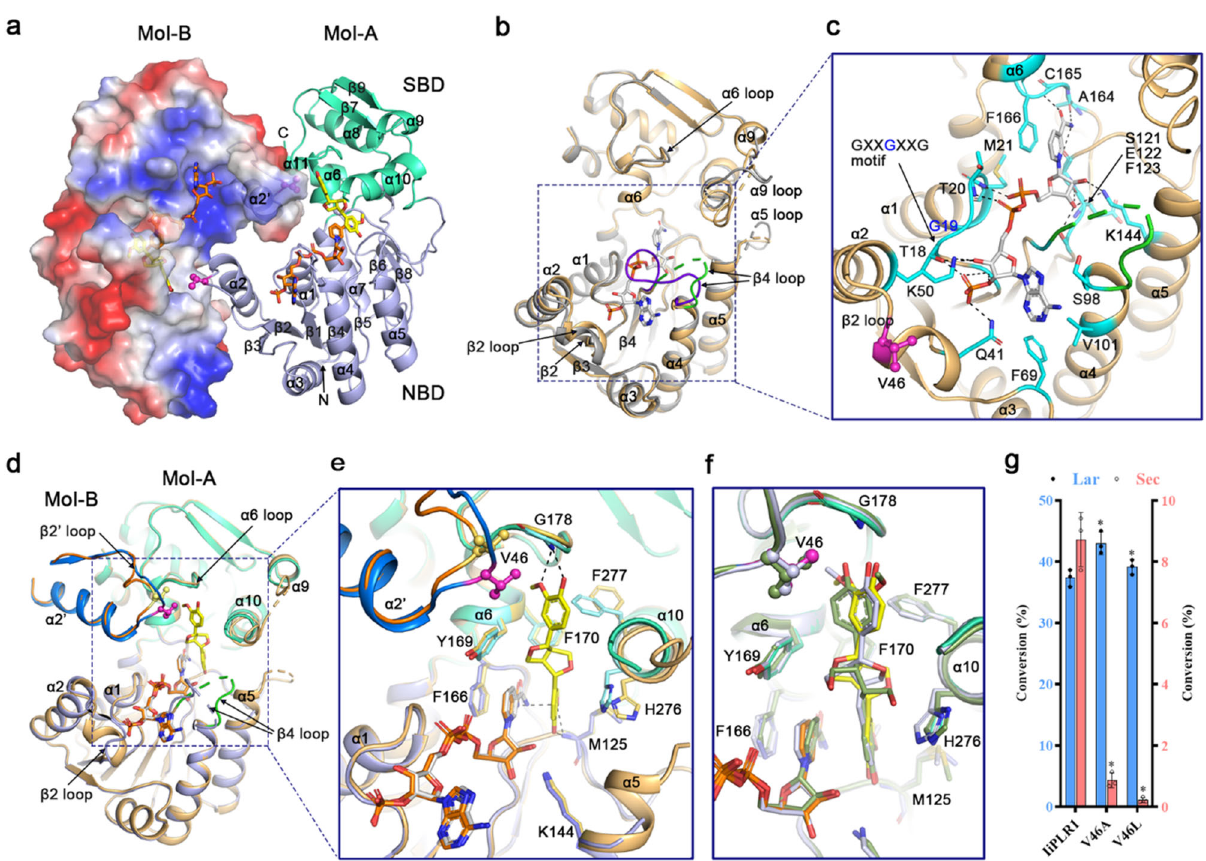
Fig. 2 Structural mechanism of continuous catalytic reactions by Ii PLR1 based on homodimerization. a Dimer formation of Ii PLR1_NAP_ + PIN. Mol-A is shown as cartoon model, with its NBD and SBD colored in light blue and green cyan, respectively. Mol-B is represented as an electrostatic-surface model, on which blue and red colors represent positive and negative charges, respectively. NADP + and ( + )-pinoresinol are shown as sticks and colored in orange and yellow, respectively. b Conformational changes were assessed by comparing monomer structures of Ii PLR1_apo (gray) and Ii PLR1_NAP (light orange). The NADP + bound to Ii PLR1_NAP is colored gray. The β 4 loops of Ii PLR1_apo and Ii PLR1_NAP are highlighted as purple and green, respectively. c Zoom-in view of the NADPH-binding groove of Ii PLR1_NAP. Residues interacting with NADP + are colored cyan. The conserved GXXGXXG motif is indicated. Residue Val46 involved in dimer formation and substrate binding is shown as a ball-and-stick model and colored magenta. Dotted lines denote possible hydrogen bonds. d Structure comparison of Ii PLR1_NAP_ + PIN and Ii PLR1_NAP. Mol-Bs of Ii PLR1_NAP_ + PIN and Ii PLR1_NAP, Val46s in Ii PLR1_NAP_ + PIN, and Ii PLR1_NAP are colored in marine, orange, magenta, and light yellow, respectively. e Zoom-in view of the substrate-binding groove. Residues of Mol-As in Ii PLR1_NAP_ + PIN and Ii PLR1_NAP are colored green cyan (or light blue) and light yellow, respectively. f Structural comparation of